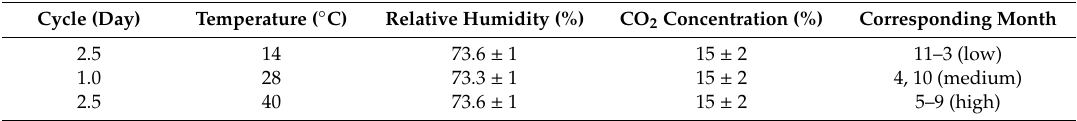
Table 4. The test system of artificial accelerated simulation